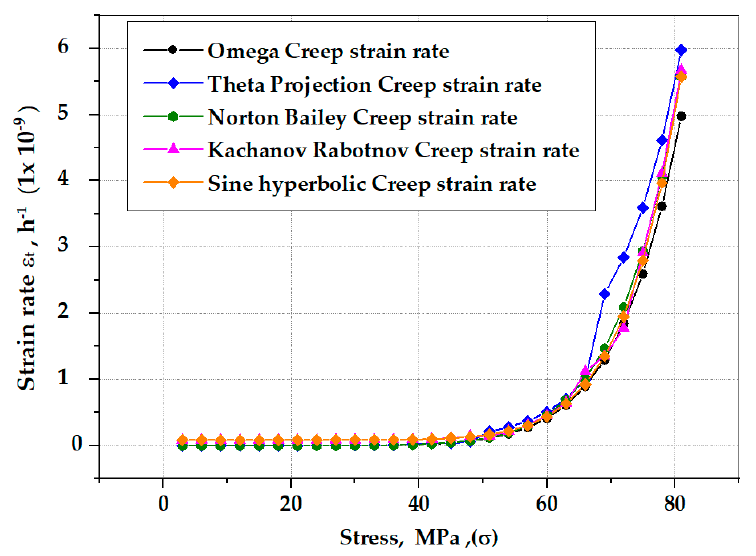
Figure 2. The resulting strain rate versus stress curve was generated by a resulting curve-fitting of MPC Omega to the NB, TP, and KR models based on strain hardening